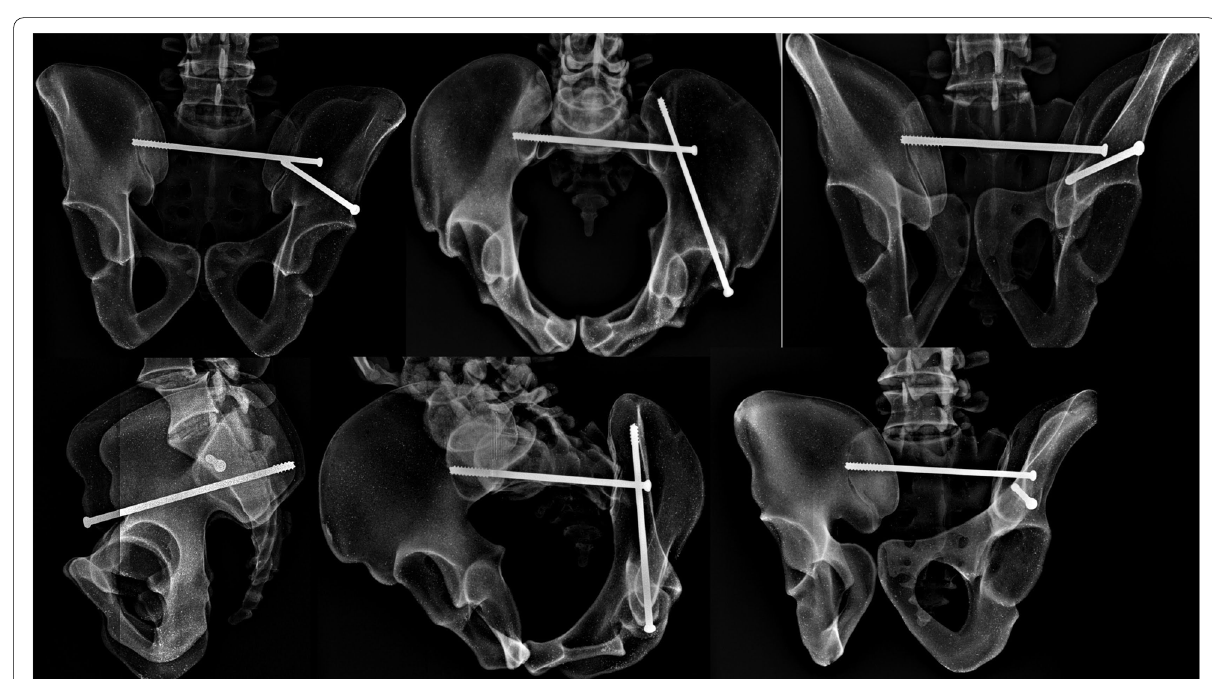
Fig. 6 AP, Inlet, Outlet, Lateral, Obturator Inlet and Obturator Outlet